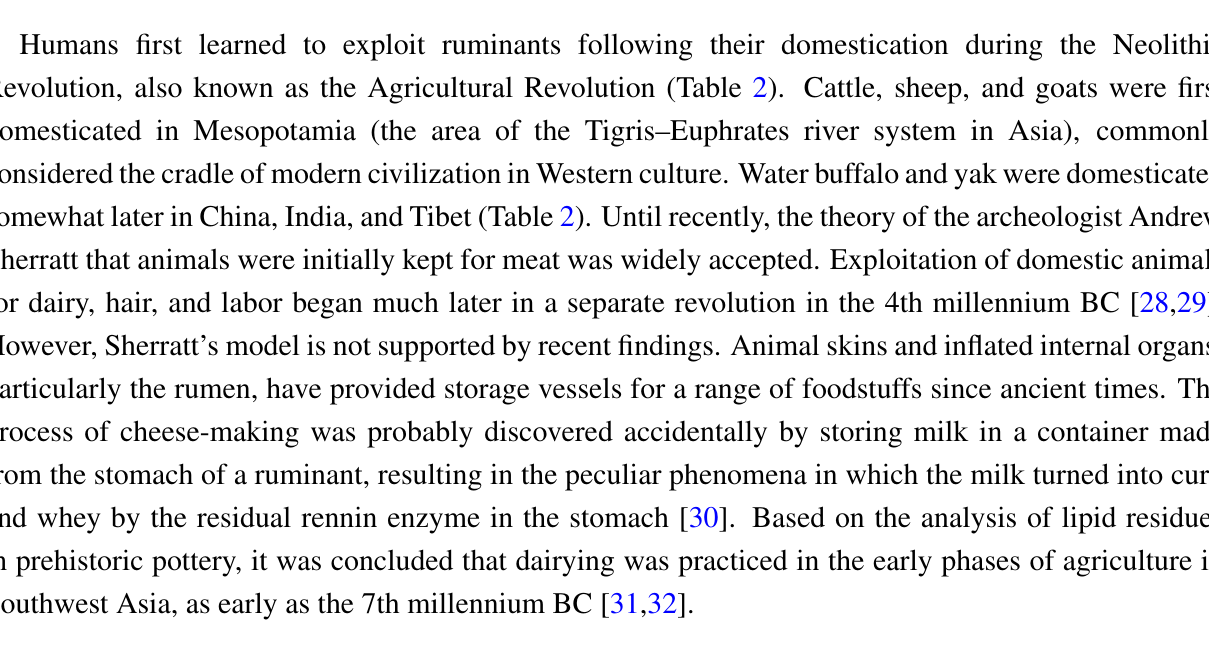
Table 2. Approximate dates and locations of ruminant